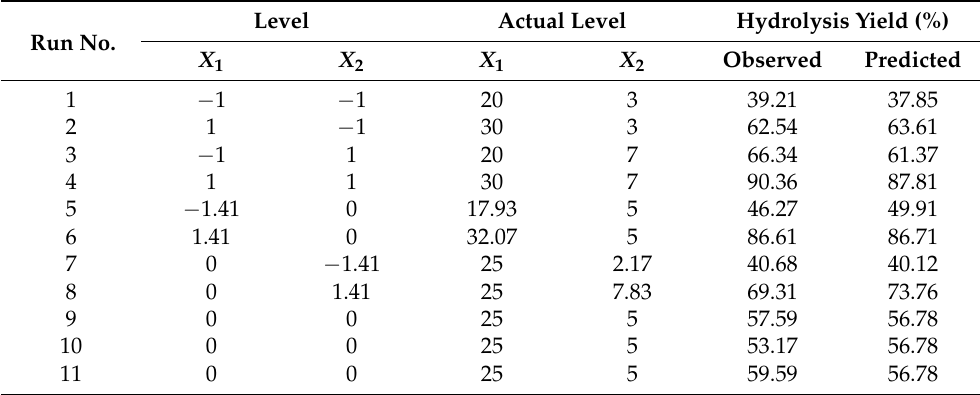
Table 1. Experimental design used in response surface methodology of two independent variables: enzyme loading ( 𝑋 1 ) and substrate loading ( 𝑋 2 ). Run No.